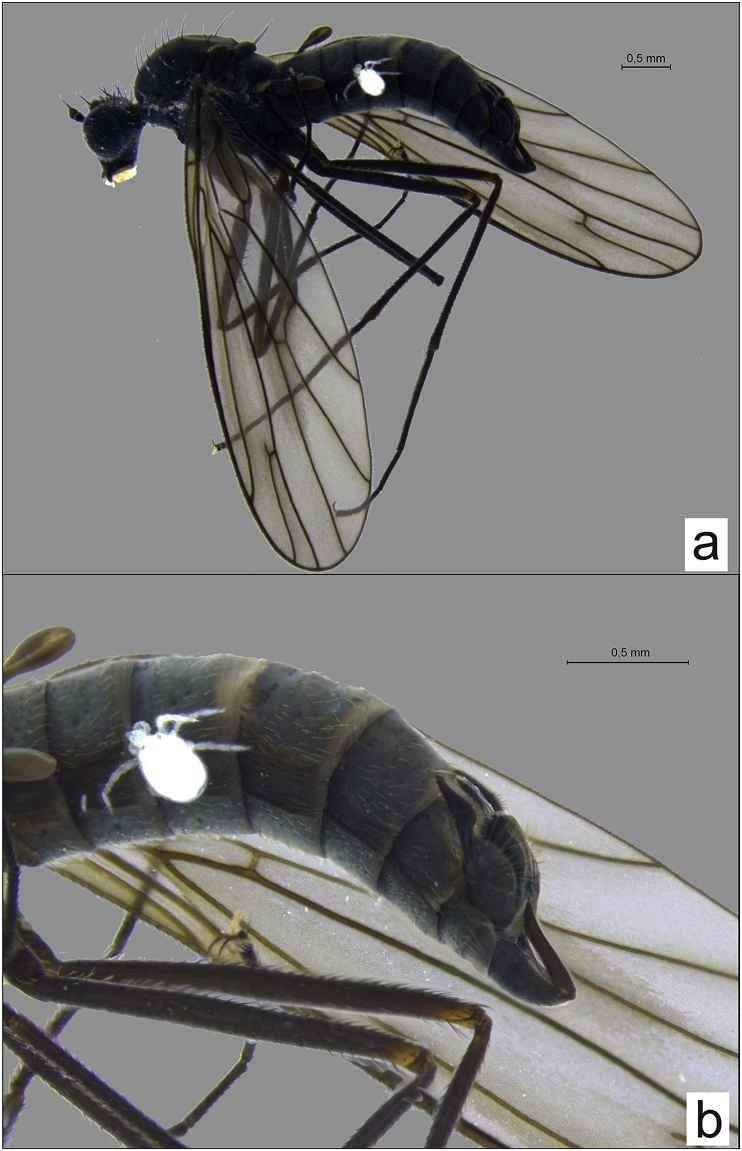
Clinocera appendiculata parasitized by Panisopsis curvifrons; a – habitus, b – abdomen.